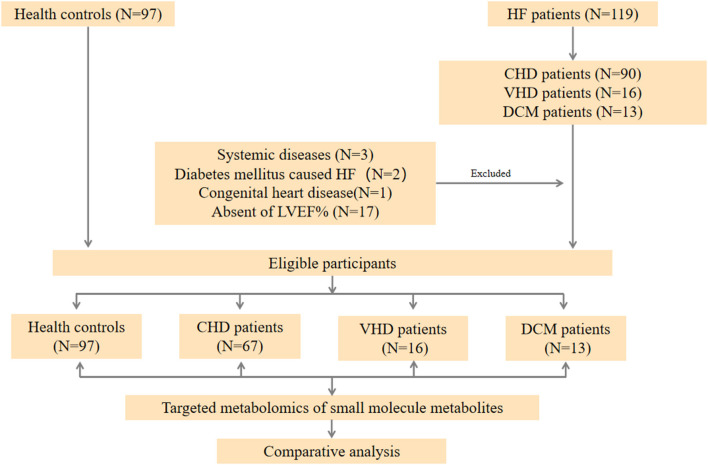
Workflow of the present study. In general, HF patients with different etiology (67 CHD patients, 16 VHD patients, and 13 DCM patient, respectively), and 96 healthy controls were enrolled in our study. A targeted metabolomics panel was applied to the plasma of these individuals. We comparatively analyzed the plasma metabolomics data of the four groups to elucidate the differences among these patients with different etiology.